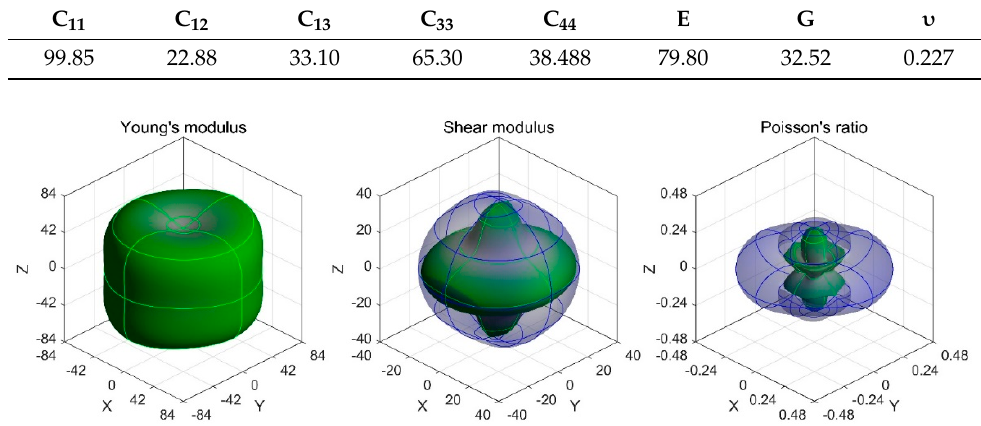
Figure 6. The calculated spatial dependent mechanical properties for the ternary phosphide BaLiP, including Young’s modulus, Shear modulus and Poisson’s ratio. All units are in GPa, except no unit for the Poisson’s ratio.